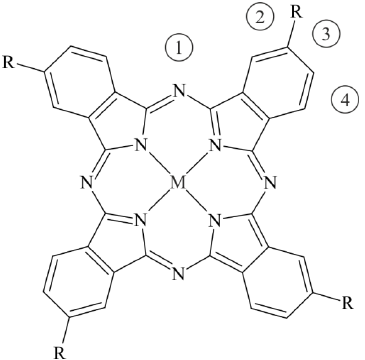
Figure 2. The structural formula of MPcR 4 monomeric phthalocyanines with C 4h symmetry. Numbers in circles denote nonequivalent attachment sites of the NO molecule.